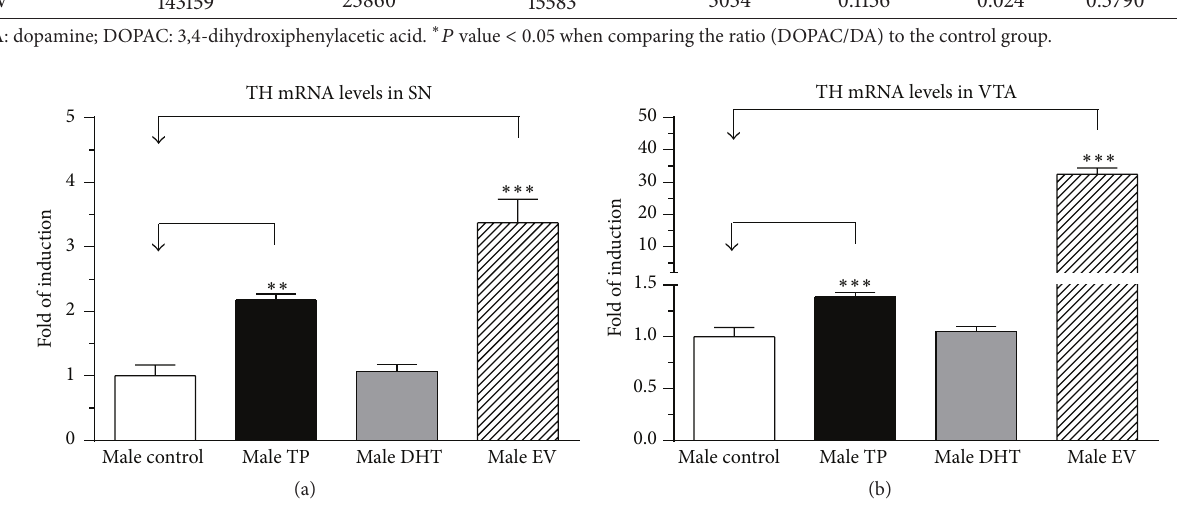
Figure 1: Effect of neonatal exposure to testosterone propionate (TP), dihydrotestosterone (DHT), or estradiol valerate (EV) on TH mRNA levels in substantia nigra (SN) (a) and ventral tegmental area (VTA) (b) of adult male rats. All data have been normalized for levels of 18s expression within the same sample. Results are expressed as fold of induction regard control group and represent the mean ± SEM (SN: 𝑛 = 4 , 4, 5, and 4 per male control, TP, DHT, and EV, resp.; VTA: 𝑛 = 4 , 3, 6, and 4 per male control, TP, DHT, and EV, resp.) ( ∗∗∗ 𝑃 < 0.0001 , ∗∗ 𝑃 < 0.01 ; one-way ANOVA followed by the Newman-Keuls multiple comparison